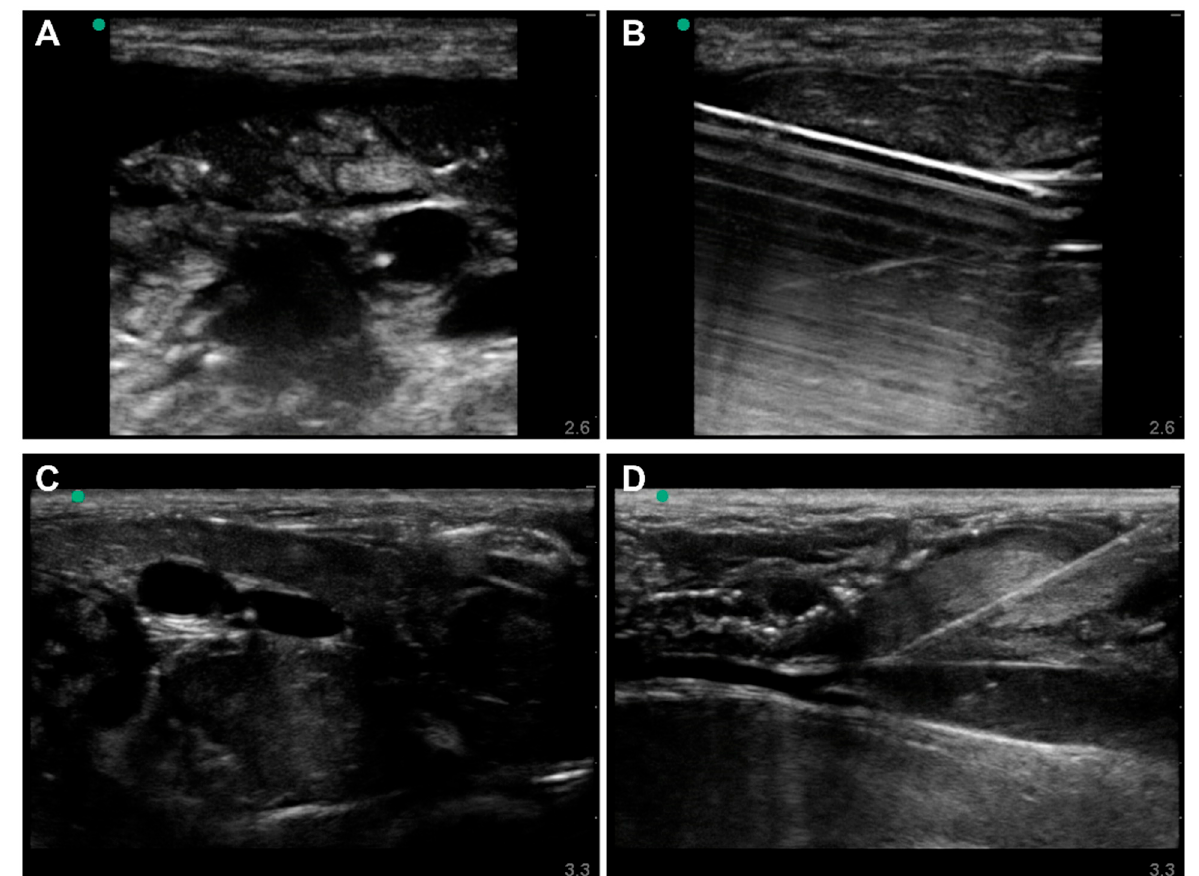
Figure 5. Lower-body Ex Vivo Porcine Model under Normovolemic Conditions. Out-of-plane ( A ) and in-plane ( B ) views of arterial needle insertion. Out-of-plane ( C ) and in-plane ( D ) views of venous needle insertion.